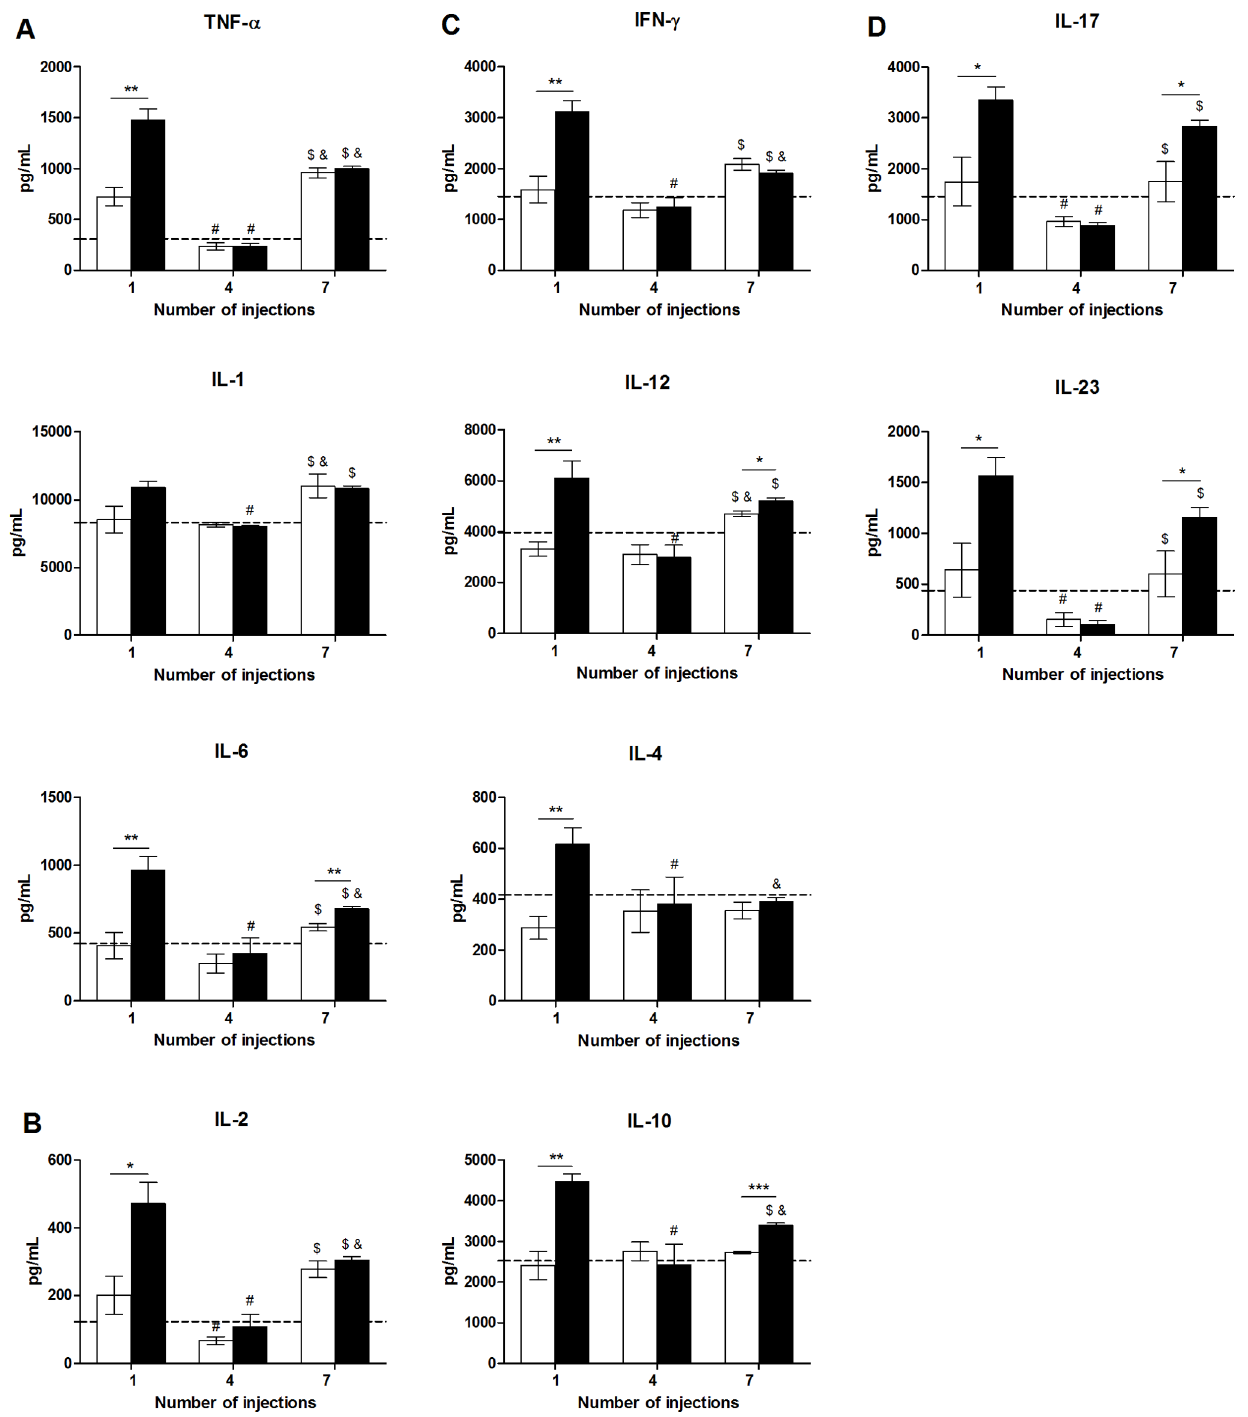
Figure 7. Concentration of paw cytokines from mice injected with Premolissemirufa bristle extract. BALB/c mice were repeatedly injected with 50 m L of pyrogen-free saline ( % ) or 10 m g (protein) of the extract ( & ) in the footpad and, after the 1 st , 4 th and 7 th inoculations, the footpads were collected and processed for cytokine analysis by ELISA. (A) Levels of innate immunity associated cytokines TNF- a , IL-1 and IL-6, (B) levels of the pro-proliferative cytokine IL-2, (C) levels of T H 1-associated cytokines IFN- c and IL-12, T H 2-associated and anti-inflammatory cytokines IL-4 and IL-10, respectively and (D) levels of T H 17-associated cytokines IL-17 and IL-23. Un-inoculated paws were used as a control for basal cytokine levels (dotted line). All graphs show mean values 6 SD. * p , 0.05, ** p , 0.01 and *** p , 0.001: significant differences between the mean values obtained with the saline group and the mean values of the P . semirufa group. The symbols indicate significant differences between the inoculations: 1 st 6 4 th ( # ), 1 st 6 7 th (&) and 4 th 6 7 th ( $ ).